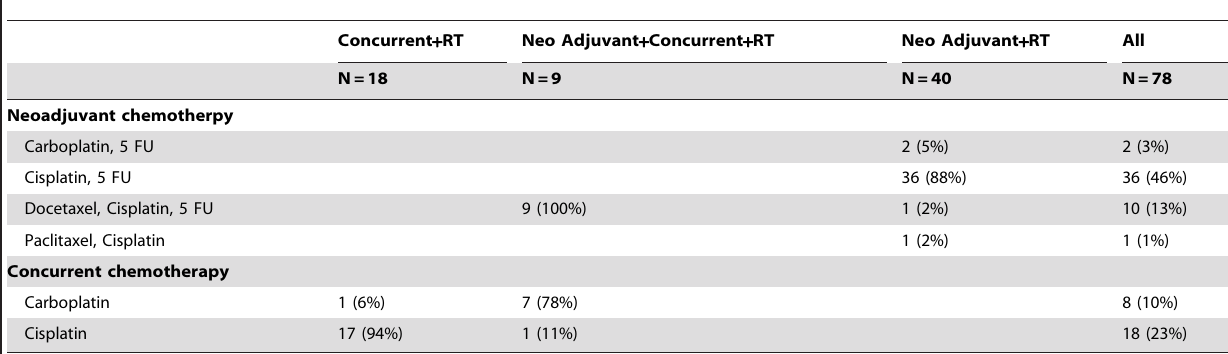
Table 2. Type of chemotherapy